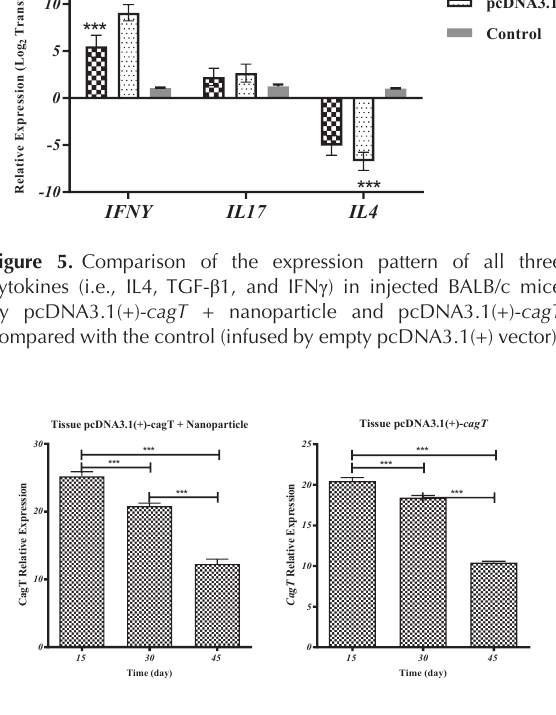
Figure 6. The comparison of the cagT gene expression in the infused BALB/c mice tissue by pcDNA3.1(+)- cagT + nanoparticle (left) and pcDNA3.1(+)- cagT (right) in different time intervals.